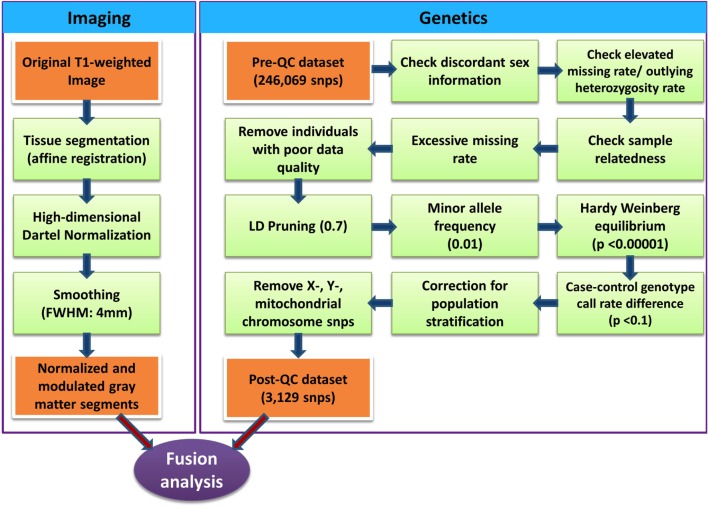
Illustration of quality control processing for SNP data and structural MR imaging data.